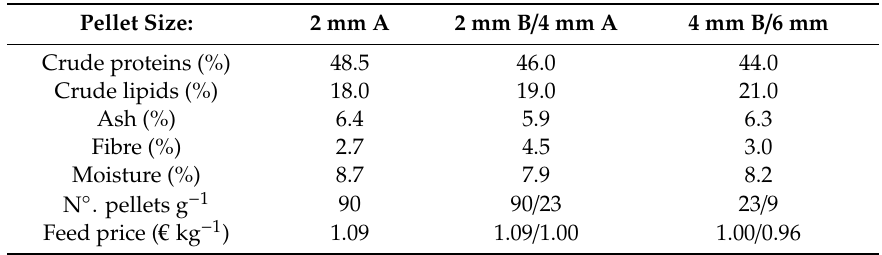
Table 2. Proximate composition, number of pellets per weight and price of the di ff erent fish feeds used in the